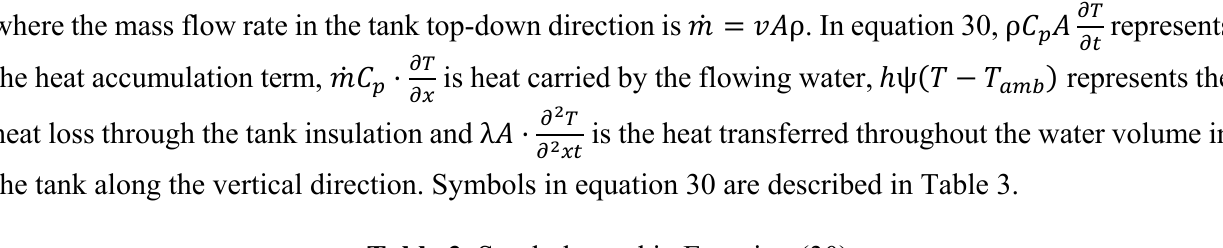
Table 3. Symbols used in Equation